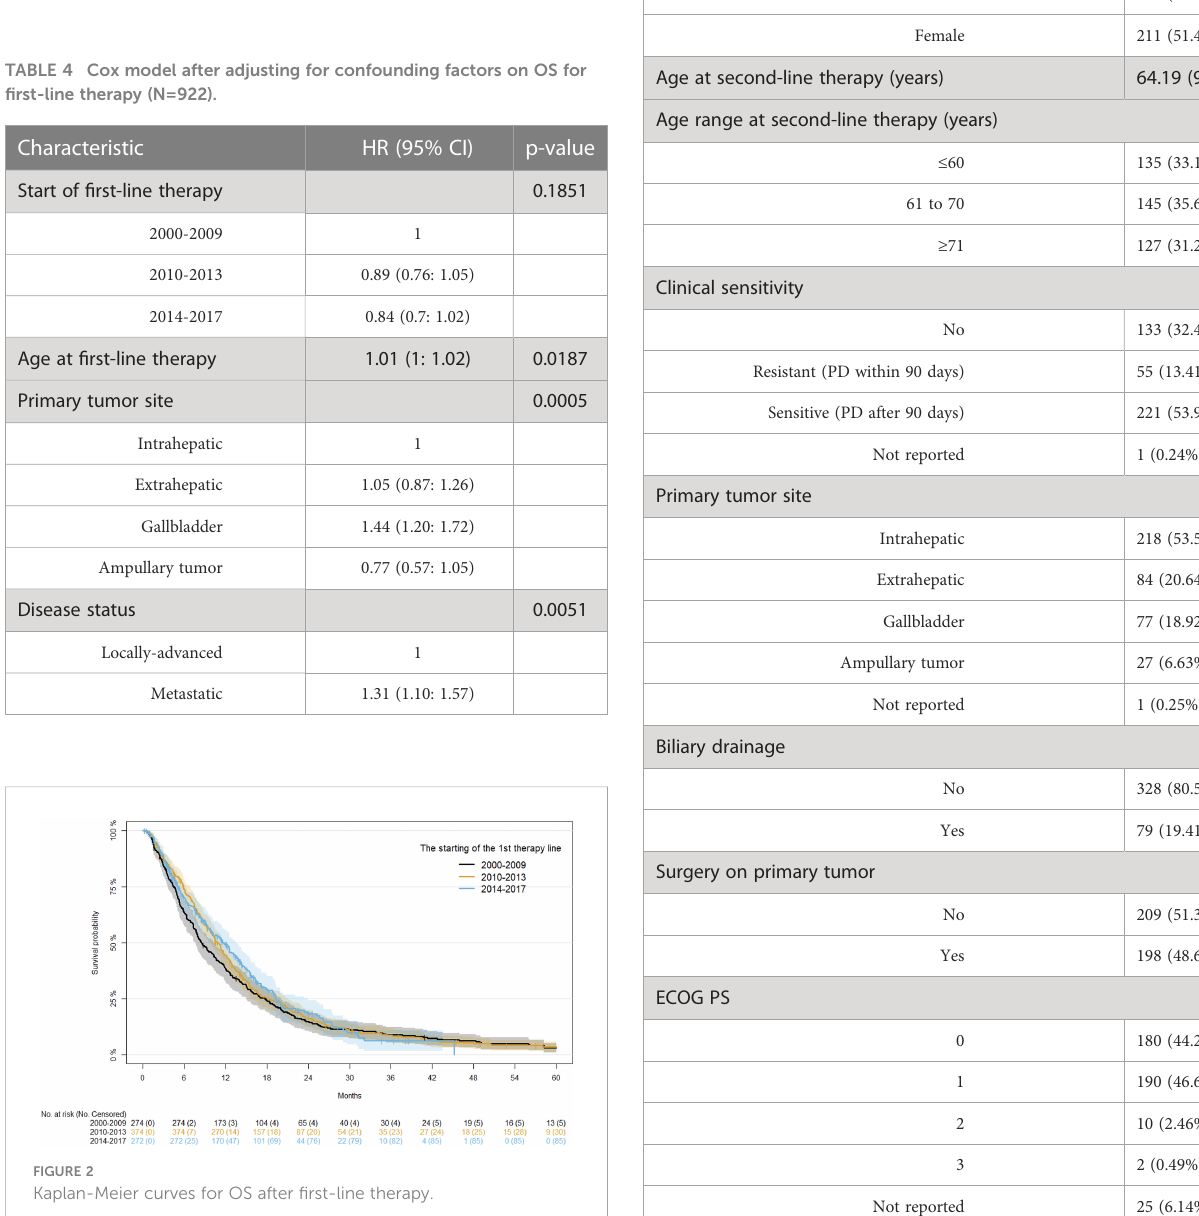
FIGURE 2 Kaplan-Meier curves for OS after fi rst-line therapy.